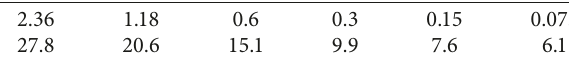
Table 2: Aggregate gradation of control asphalt mixture.